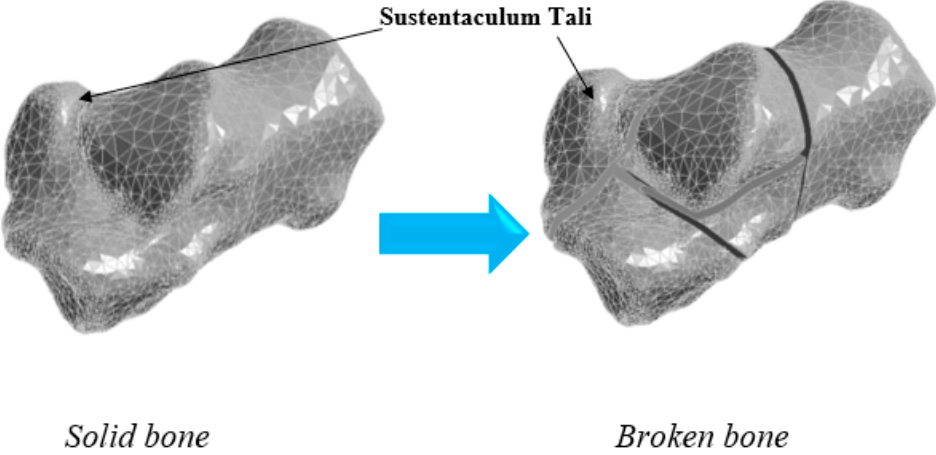
Figure 16. The adjustment of the bone model for calculations.